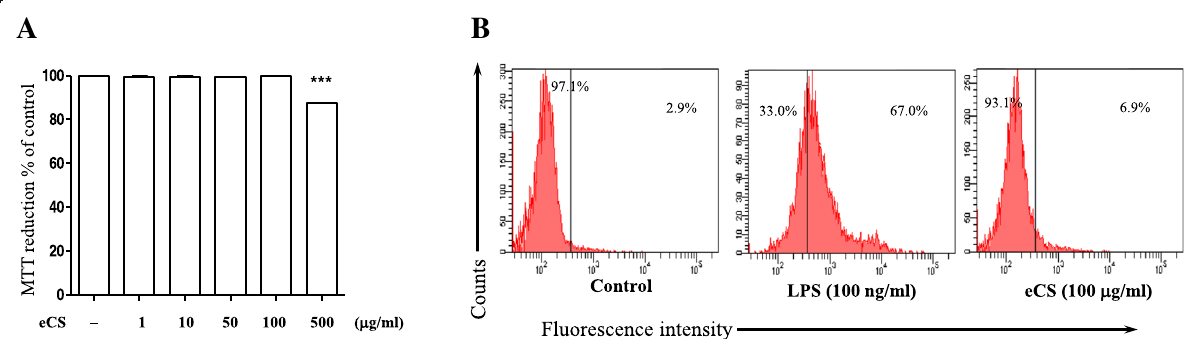
Fig. 2 Cytotoxicity of eCS. Cytotoxicity induced by eCS ( a ) was determined by an MTT assay using RAW 264.7 cells. Data represent the mean ± SEM in triplicate. *** P was less than 0.0001, compared to the untreated control. b Intracellular ROS generated in RAW 264.7 cells after treated with eCS (100 μ g/ml) for 16 h were measured by a flow cytometer. Treatment with LPS (100 ng/ml) for 16 h was included as a positive control for intracellular ROS. The percentiles of ROS-positive cells are shown in the right columns